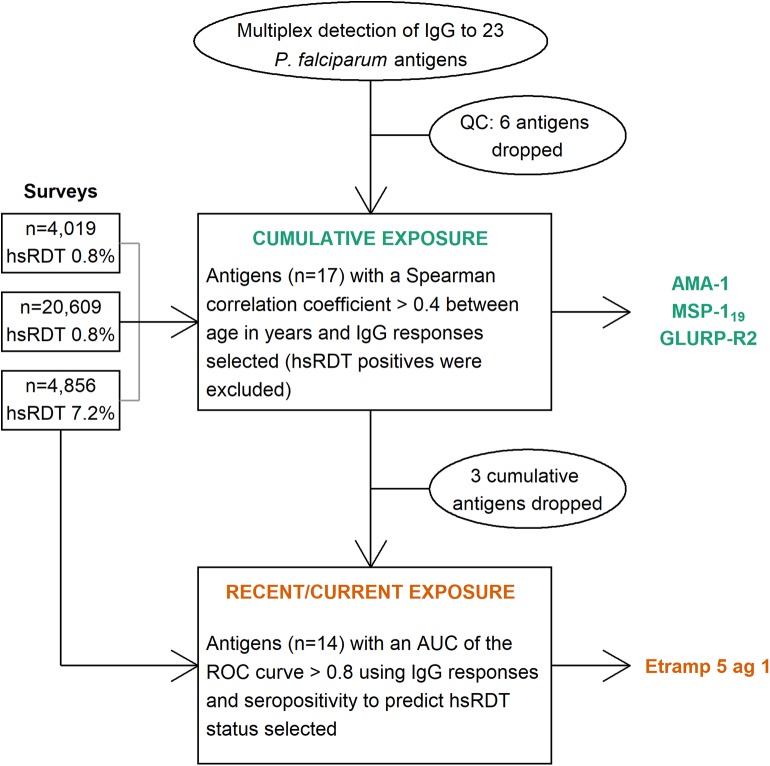
Flowchart of the selection process for immunoglobulin G (IgG) responses to Plasmodium falciparum antigens representative of cumulative and current or recent exposure. QC: quality control, hsRDT: highly sensitive rapid diagnostic test, AUC: area under the curve, ROC: receiver operating characteristic, AMA-1: apical membrane antigen 1, MSP-119: 19 kilodalton fragment of merozoite surface protein 1, GLURP-R2: glutamate rich protein R2, Etramp 5 ag 1: early transcribed membrane protein 5.